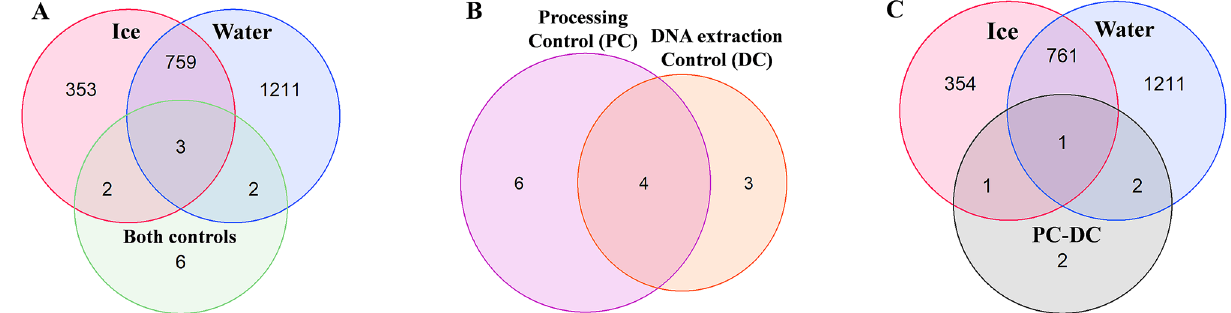
Figure 2. Specificity and sharedness of prokaryotic OTUs across environmental samples (interface water and ice) and controls. Venn diagrams display the number of ( A ) OTUs common and specific to environmental water, environmental ice, and both control samples, ( B ) OTUs common and specific to the processing control (PC) and the DNA extraction control (DC), and ( C ) OTUs common and specific to environmental interface water and ice samples comparing with PC-DC (contaminant OTUs exclusive from processing control). In diagrams ( A ) and ( C ) replicate samples within each sample type were pooled together.